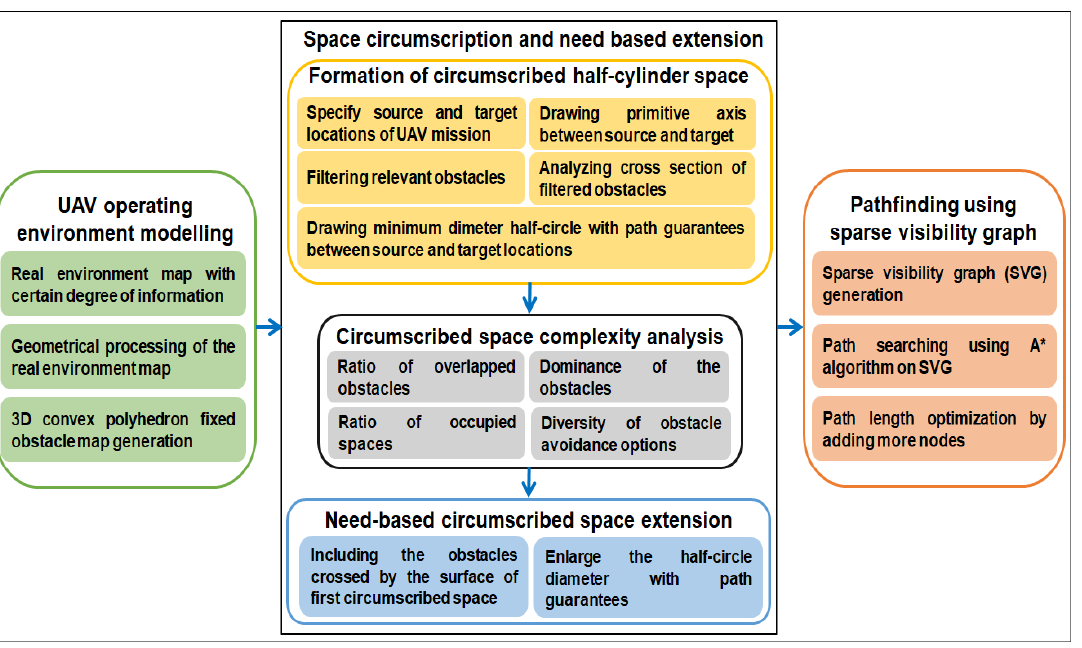
Figure 2. Conceptual overview of the proposed global flight path planning